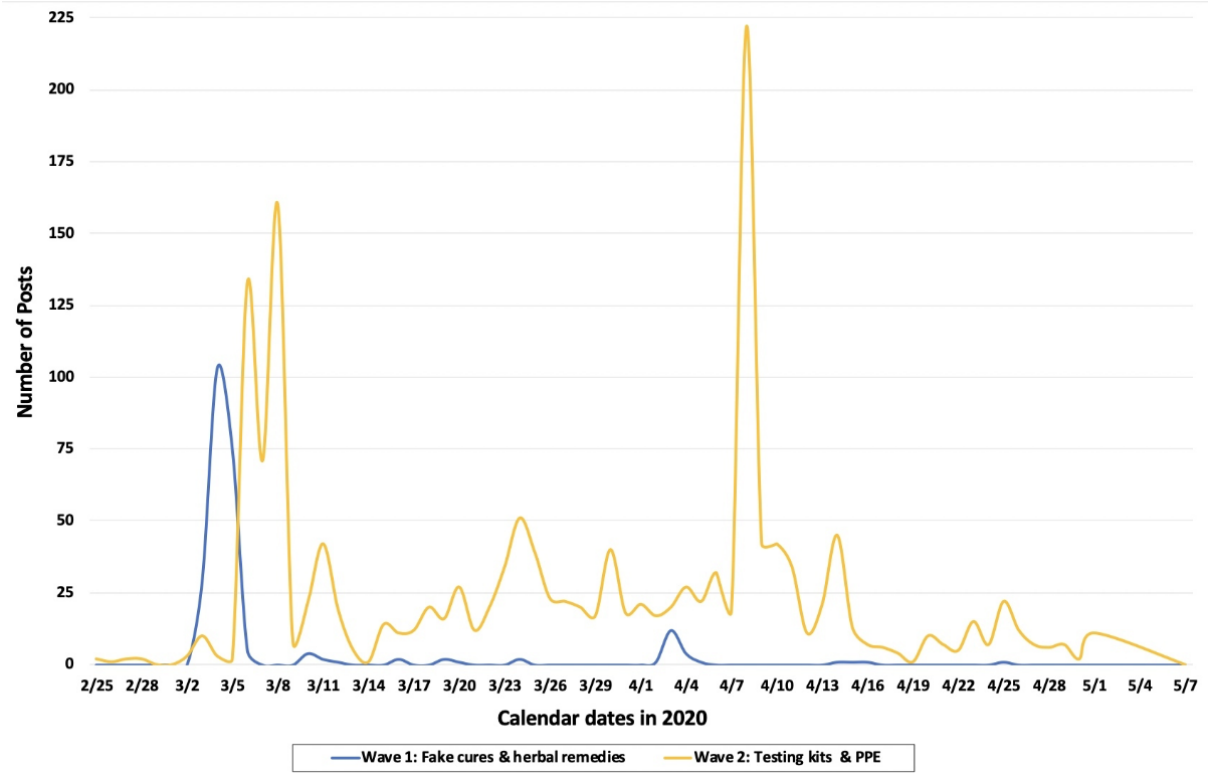
Figure 2. Timeline for volume and topics of signal posts related to suspect coronavirus disease products on Twitter and Instagram. PPE: personal protective equipment.